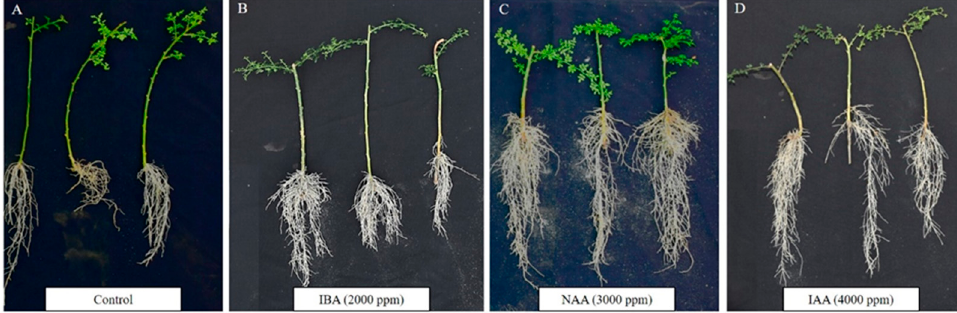
Figure 4. Root formation in Jasminum parkeri cuttings as affected by different auxin treatments.